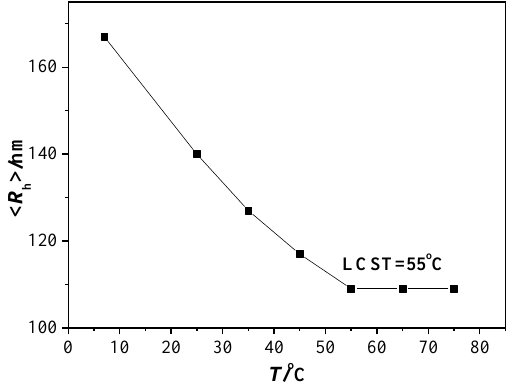
Figure 7. Temperature-dependence of the R h of polymeric micelles S3.